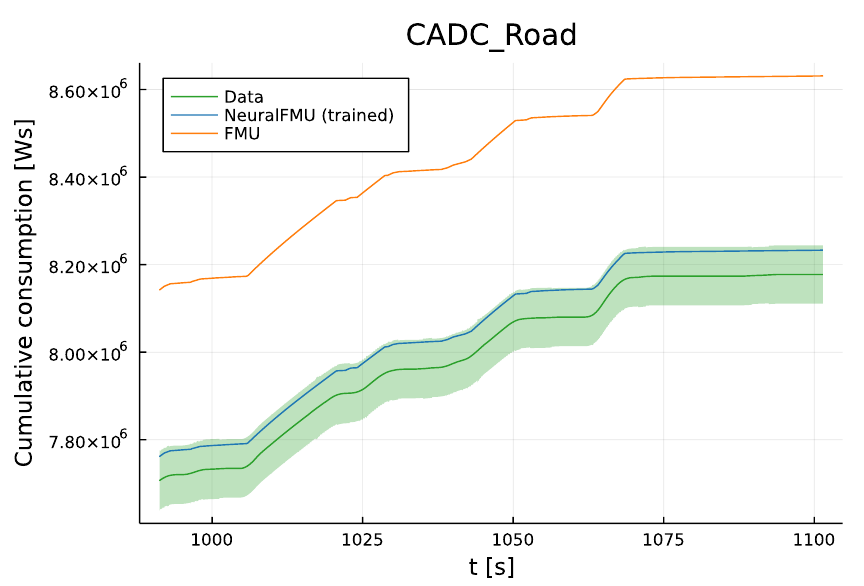
Figure 11. Deviation on the last 10% of the cumulative consumption prediction on the CADC Road , which is part of the training data. The final consumption prediction accuracy of the NeuralFMU (blue) significantly increases compared to the original FMU (orange), lies inside the measurement uncertainty (green, translucent) and close to the data’s mean (green). The original FPM prediction lies completely outside of the measurement uncertainty.